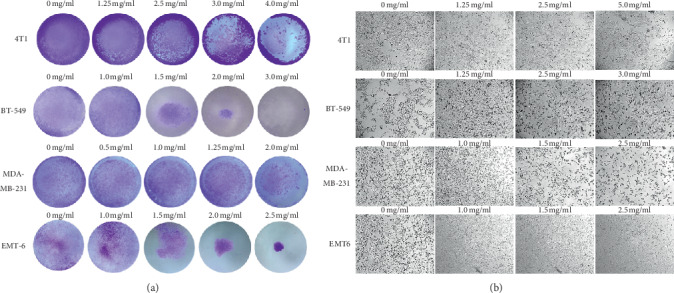
(a) Analysis of cell viability by the crystal violet assay; 4T1, BT-549, MDA-MB-231, and EMT6 cells were exposed to RLT-03 for 72 h, and cell viability was inhibited in a concentration-dependent manner. (b) 4T1, EMT6, BT-549, and MDA-MB-231 cell morphology changed, and cell death was observed after exposure to RLT-03 for 72 h.